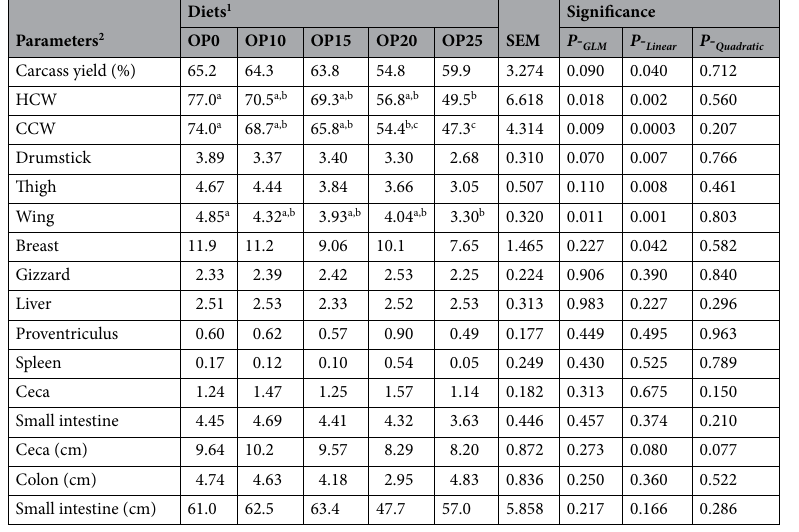
Table 5. Effects of incremental levels of dietary olive pomace on carcass performance and organ development (g, unless stated otherwise) in Jumbo quail. a– c In a row, means with common superscripts do not differ ( p < 0.05). 1 Diets: OP0 a standard grower diet without olive pomace, OP10 a standard grower diet with 100 g/ kg olive pomace, OP15 a standard grower diet with 150 g/kg olive pomace, OP20 a standard grower diet with 200 g/kg olive pomace, OP25 a standard grower diet mixed with 250 g/kg olive pomace. 2 Parameters: HCW hot carcass weight, CCW cold carcass weight.